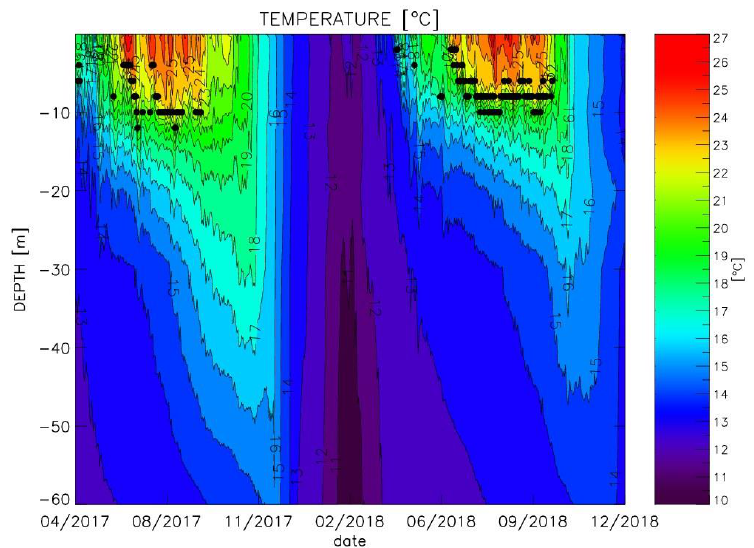
Figure 5. Vertical temperature profile and thermocline (black dots) over time in Montante during the period April 2017 to December 2018. The bottom of the graph (60 m) represents the bottom last thermistor depth and not the bottom of the reservoir.